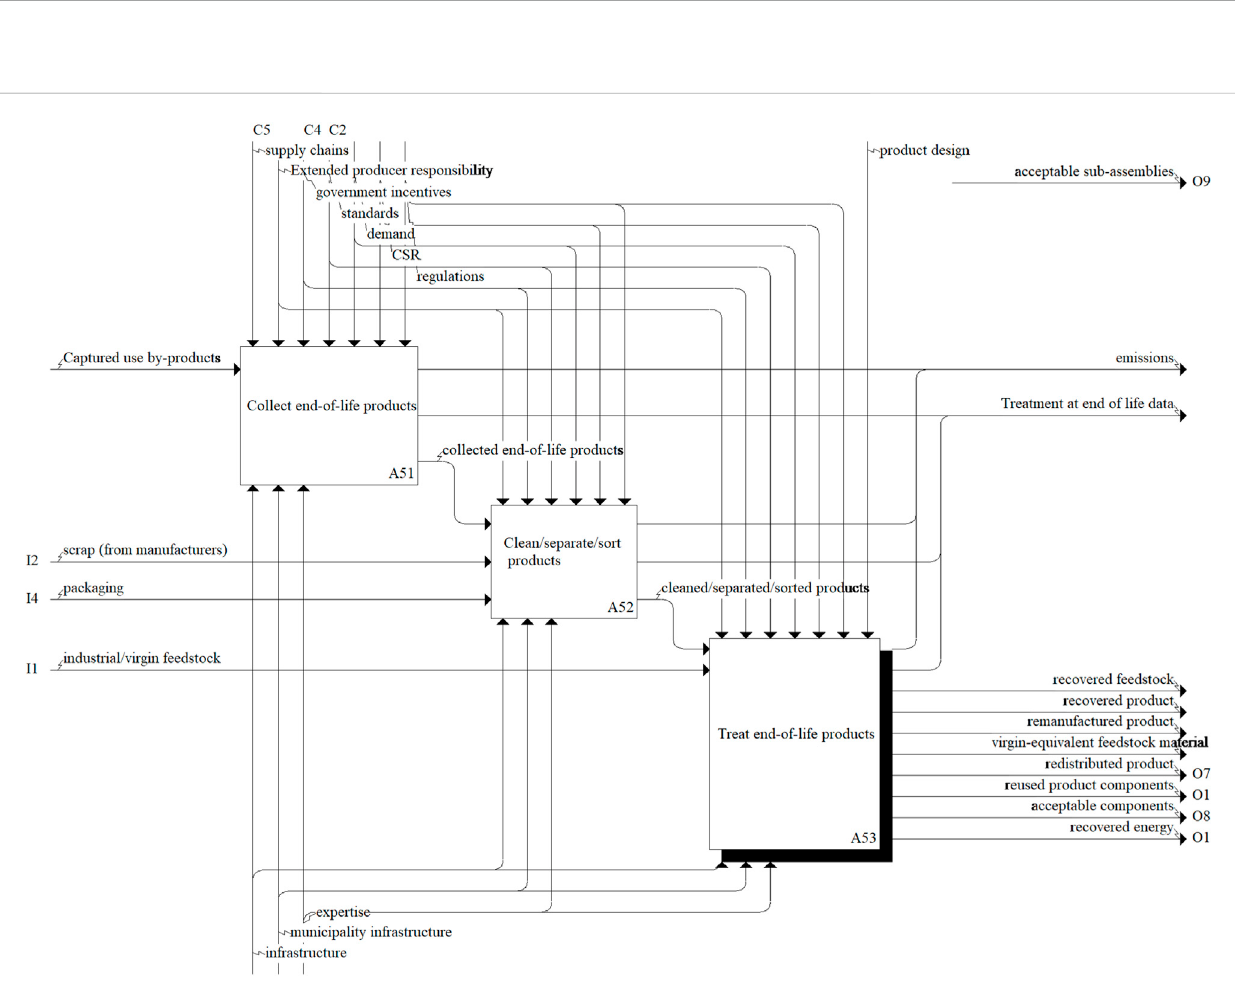
FIGURE 6 A5 Treat EoL products phase in the context of the manufacturing CE IDEF0